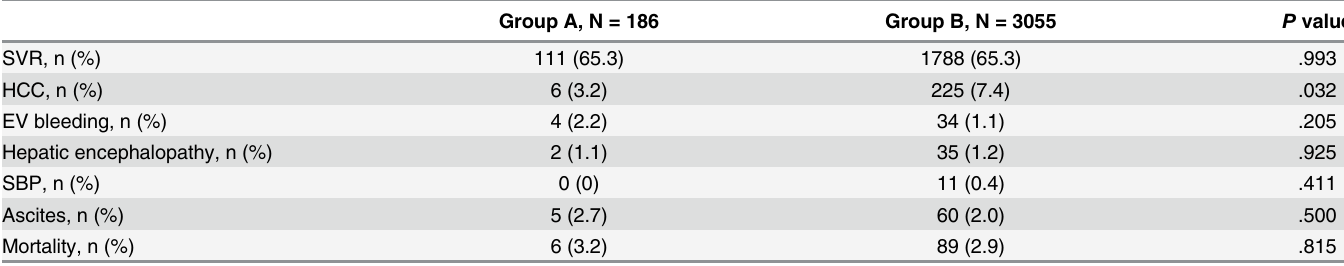
Table 2. Outcomes between Patients with PNALT and Elevated ALT